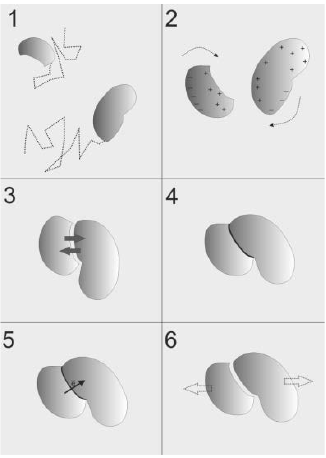
Fig.3. Stages of electron transfer between proteins in solution. 1. Diffusion motion (translational and rotational). 2. Mutual orientation of interacting proteins under the action of Brownian and electrostatic forces. 3. Formation of a mutual configuration (‘preliminary complex’). 4. Transition from the preliminary to the final complex. 5. Transfer of an electron between